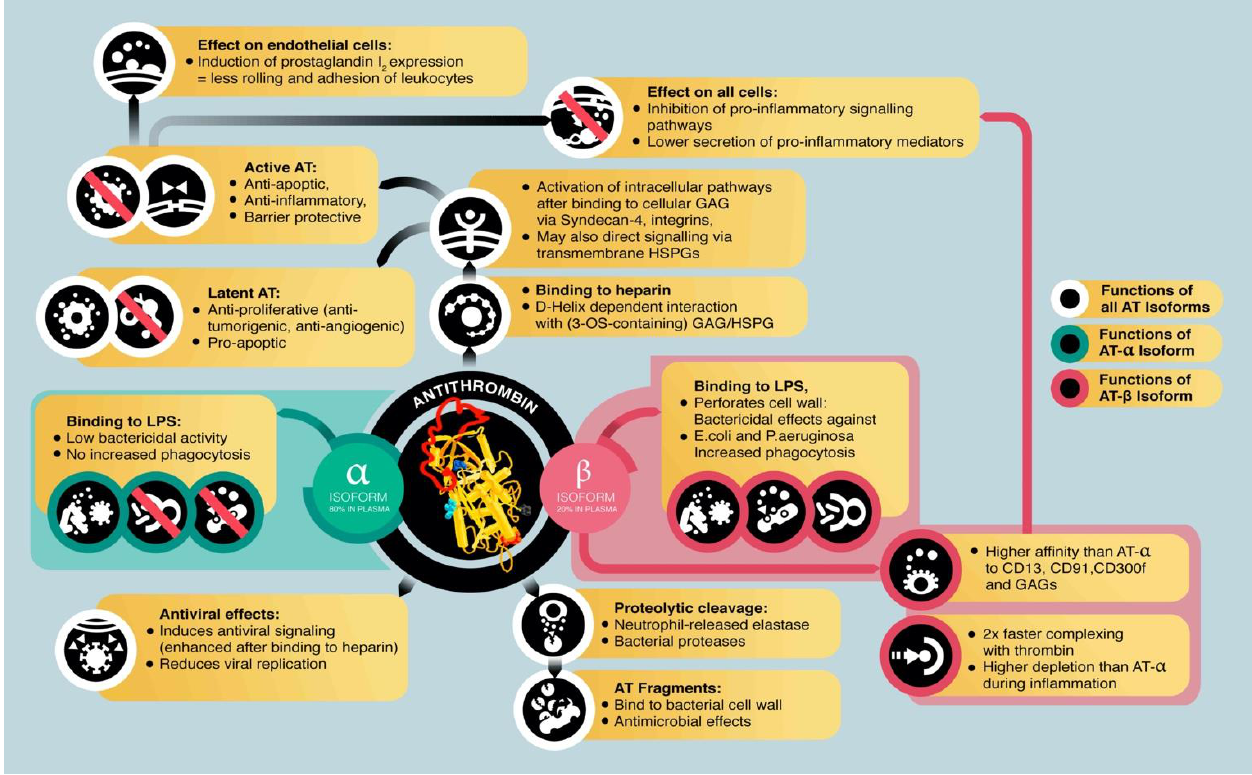
Figure 1. Functions and effects of antithrombin (AT) and AT isoforms in host defense and inflammation. LPS = lipopolysaccharide; HSPG = heparan sulfate proteoglycans; GAG = glycosaminoglycans